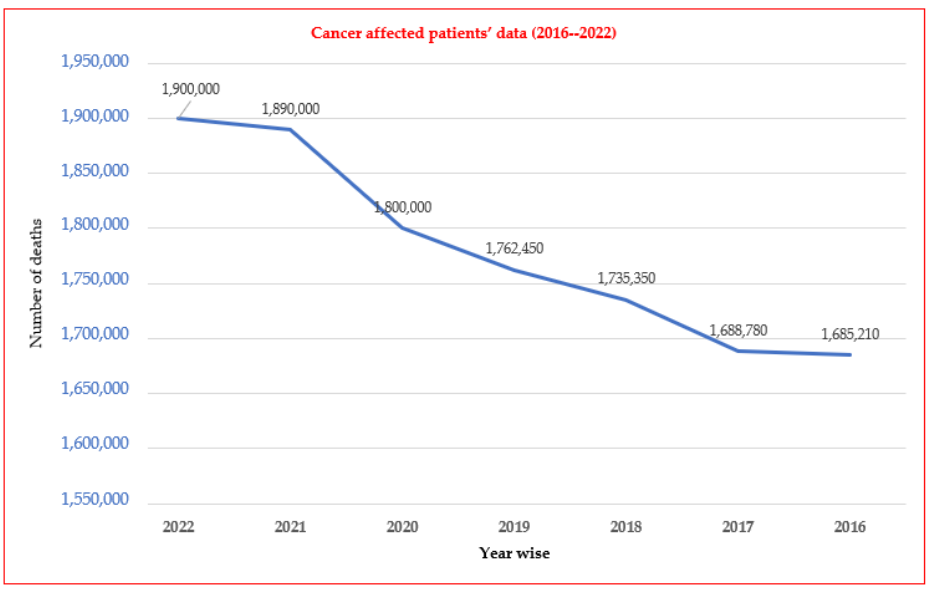
Figure 1. Cancer affected patients per year [4].